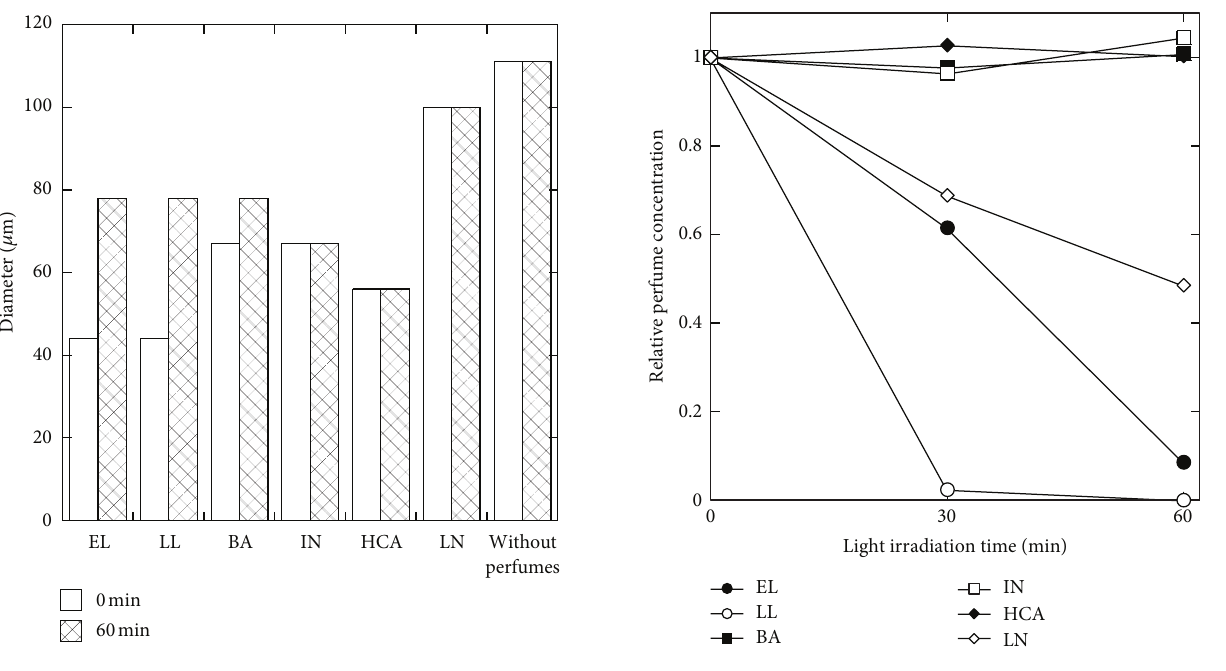
Figure7:Concentrationofsyntheticperfumesdissolvedintowater- ethanol mixed solvent after light